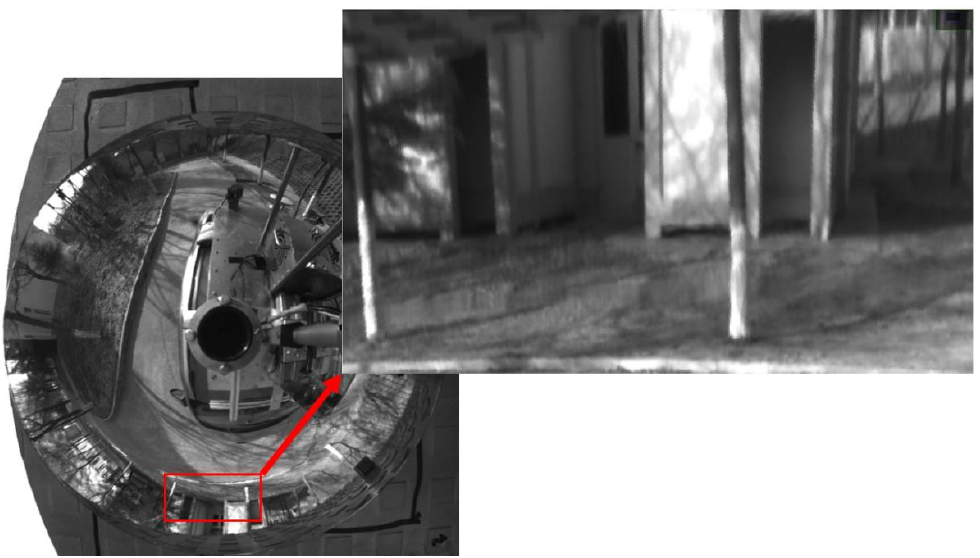
Figure 31. Effect of partial expansion.